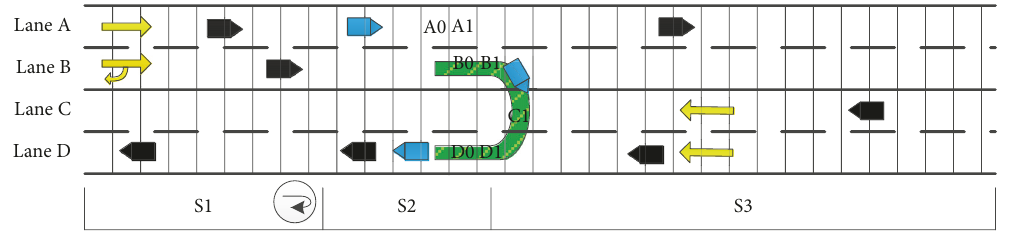
Figure 5: Scene of vehicle U-turn cellular automata